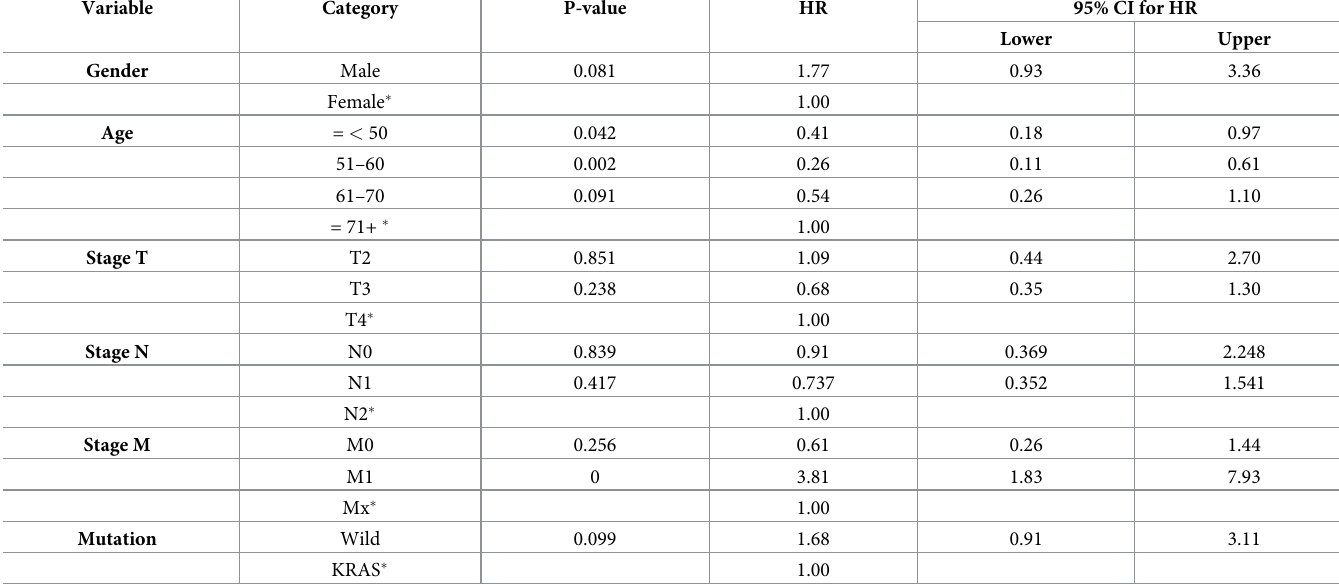
Table 2. Results of Cox regression analysis of the hazard ratios stratified patients’ gender and age, tumour stage and mutational status.